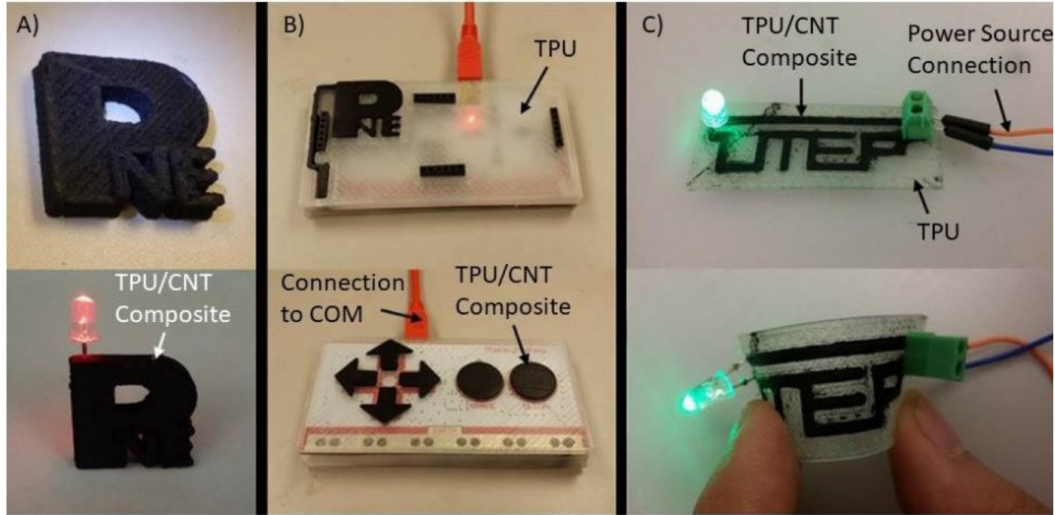
Figure 9. Prototypes of 3D-printed electronic devices made from TPU / CNT (10 wt %); ( A ) PNE lab logo, ( B ) joystick with MakeyMakey Printed Circuit Board(PCB), and ( C ) flexible